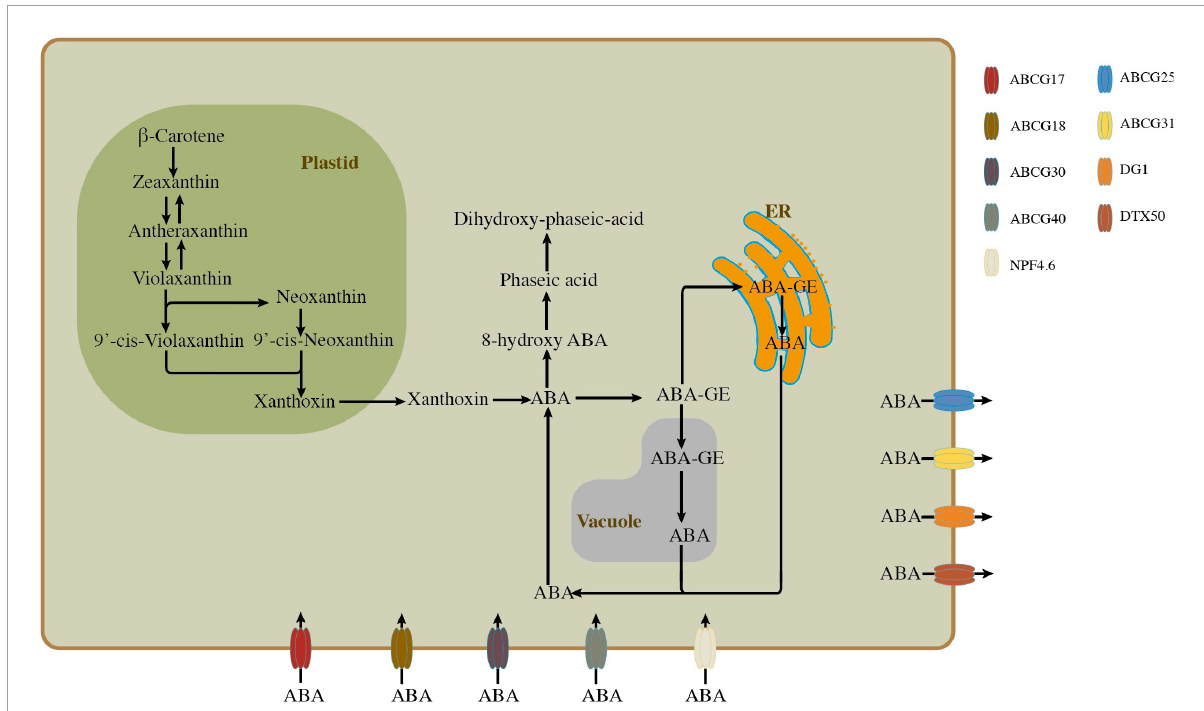
FIGURE1 Overall scheme for abscisic acid (ABA) biosynthesis, catabolism, and transport in plant. The pathways of ABA biosynthesis, catabolism, and directions of ABA transport are shown with black arrows. The ABA transporter proteins located on the plasma membrane are represented by different